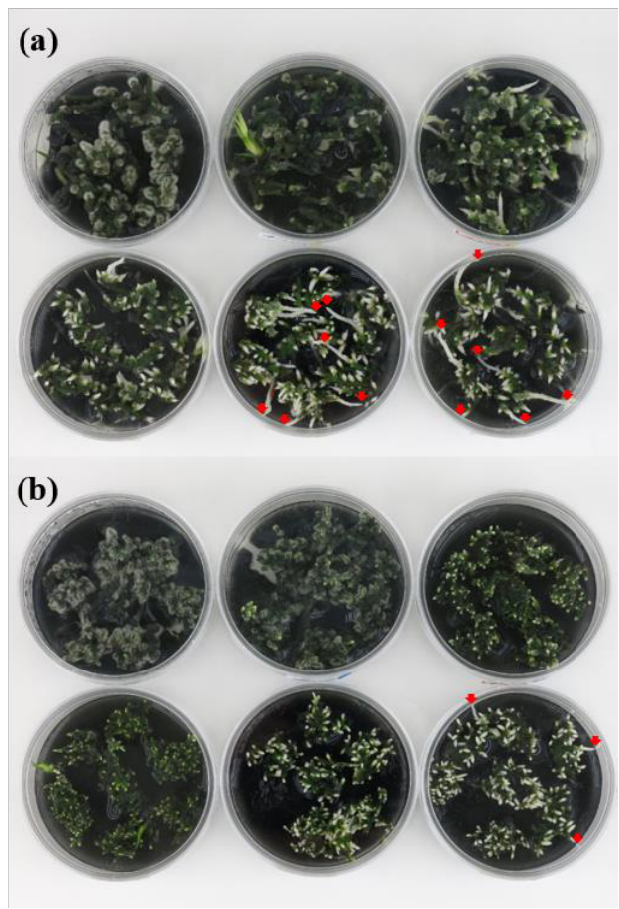
Figure 1. Chlorophyll degradation after dark treatment in rhizomes of Cymbidium hybrids RB003 and RB012. ( a ) RB003; ( b ) RB012. From the upper left: 0, 20, 40, 60, 75, and 90 days after dark treatment. Red arrows indicate the initial regeneration of the rhizomes.